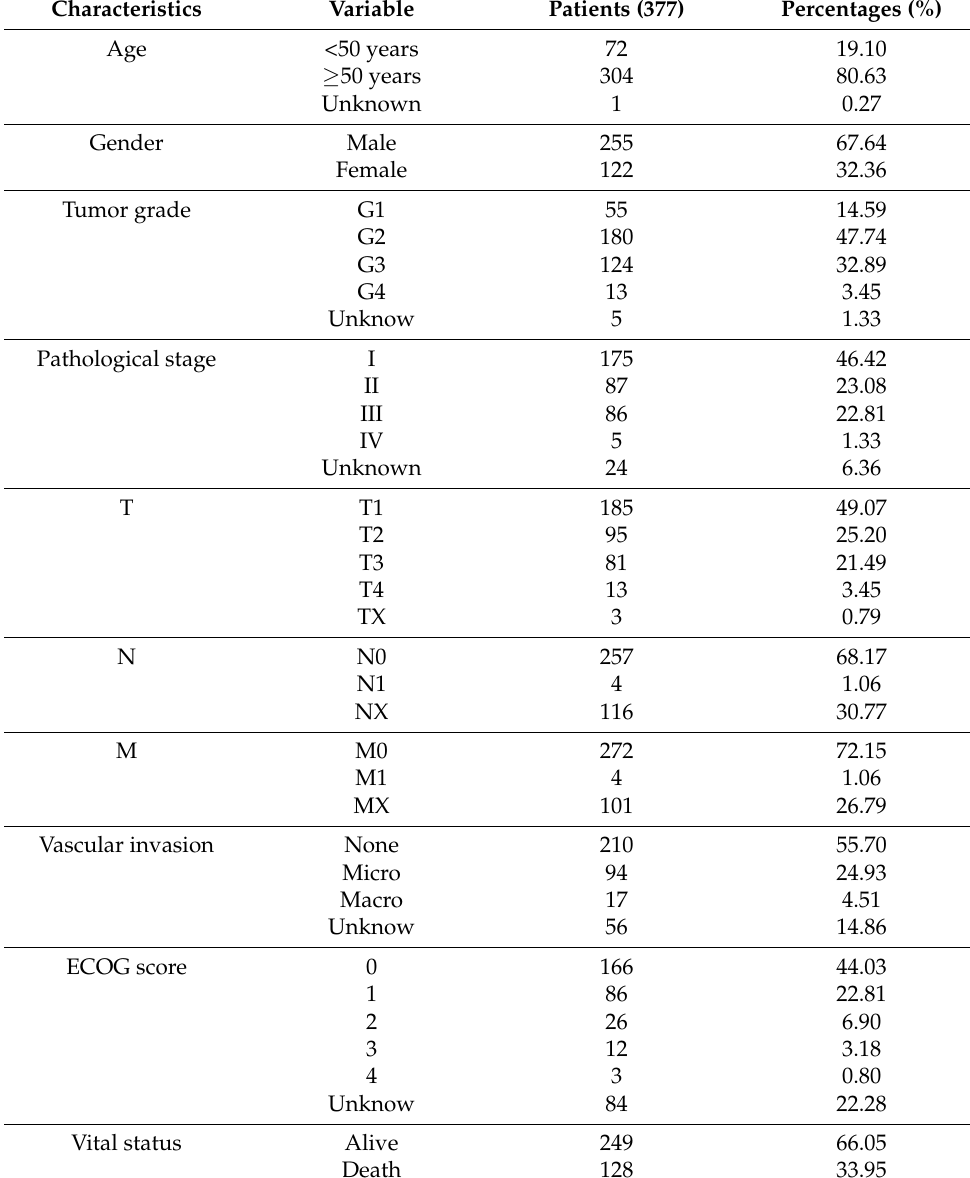
Table 1. Characteristics of the HCC